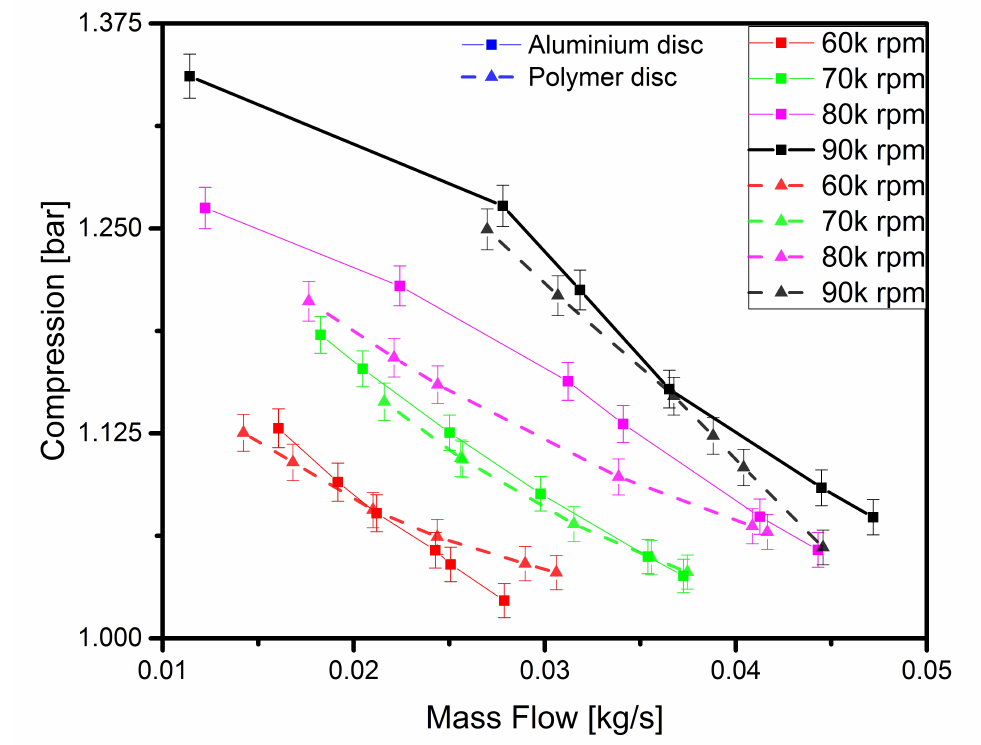
Figure 4. Compressor characteristics obtained experimentally with an aluminium (solid line) and polymer (dotted line)